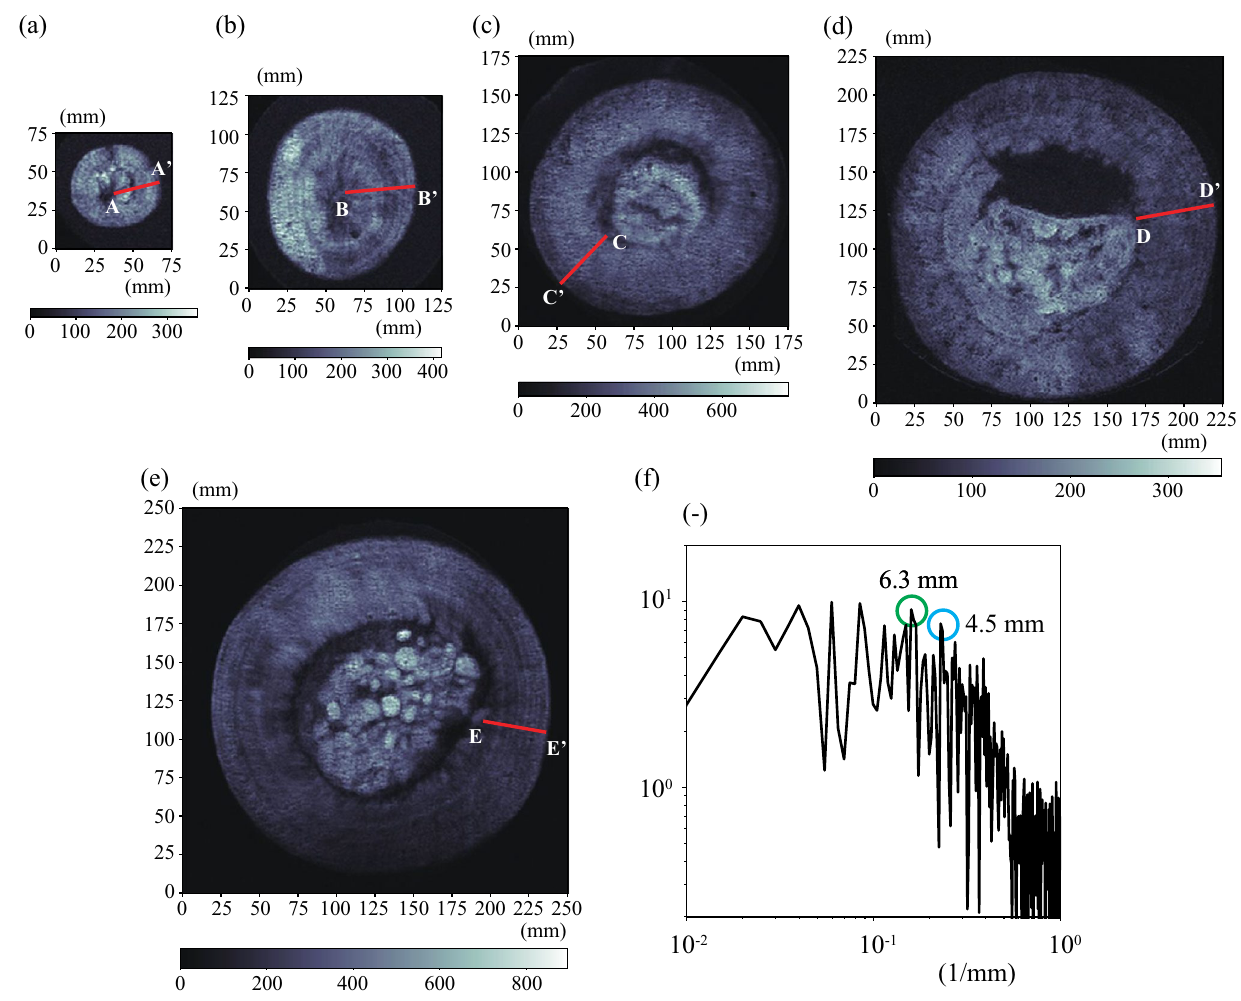
Figure 3. Magnetic resonance images. ( a ) Diameter of 6.0 cm, ( b ) Diameter of 10.0 cm, ( c ) Diameter of 16.0 cm, ( d ) Diameter of 20.0 cm, ( e ) Diameter of 22.0 cm, ( f ) Spectrum of MRI values along red